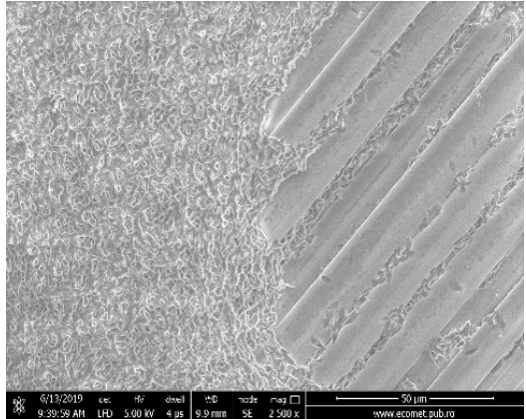
Figure 1. Scanning electron microscopy (SEM) image of fiberglass (right side) and painted (covered) with polylactic acid (PLA) solution (left side).